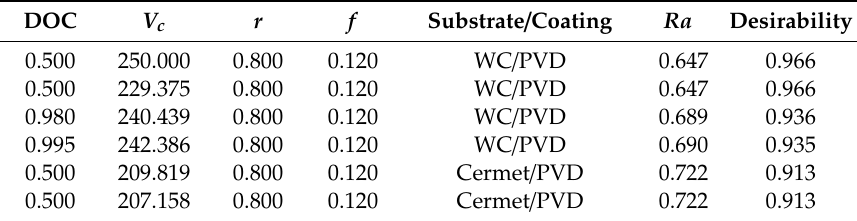
Table 10. Solutions for the Ra response optimization.